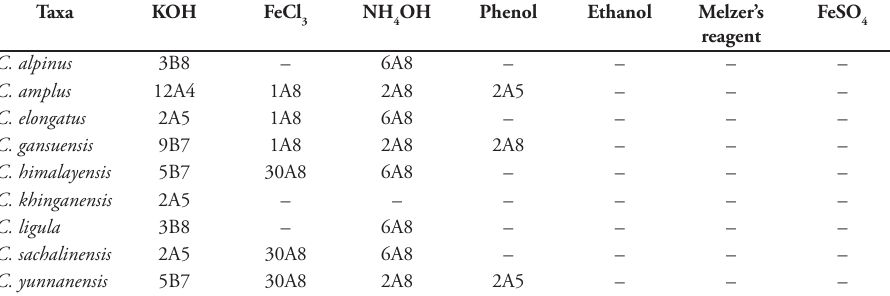
Table 1. Chemical reactions of representative species of Clavariadelphus from China.